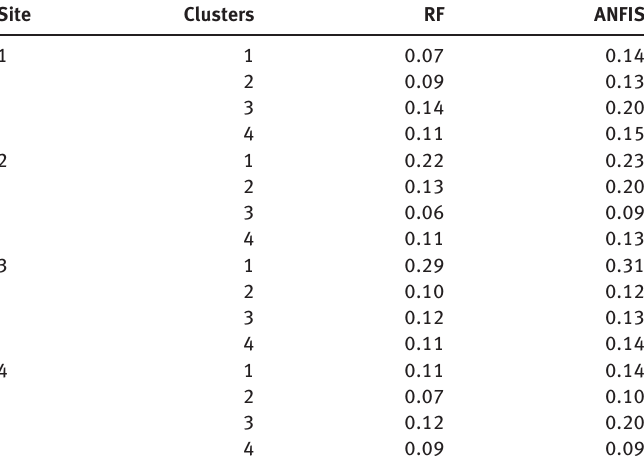
Table 9: Performance Respective to the RMSE for the Two Models RF and ANFIS within the Four Clusters. Site